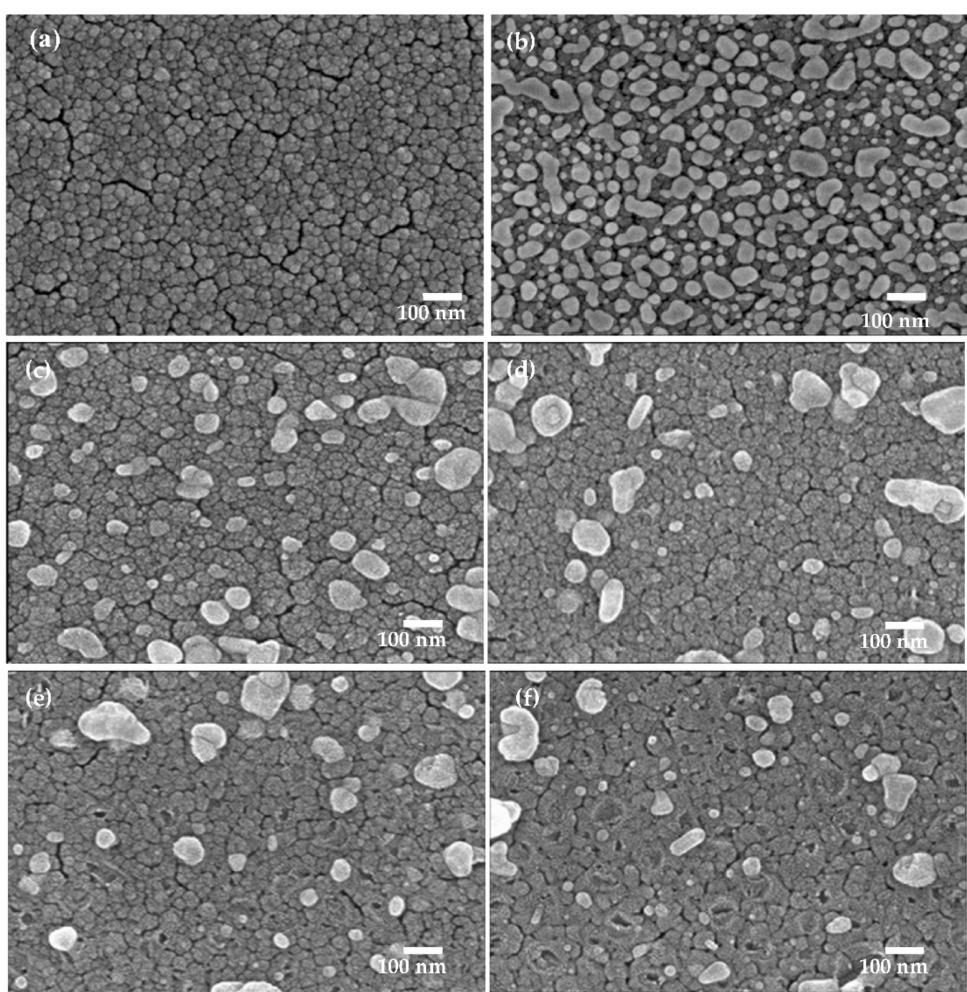
Figure 5. Surface morphologies of ( a ) the TiO x film, ( b ) the as-deposited TiO x /Ag structure, and the structures annealed at ( c ) 300, ( d ) 400, ( e ) 500, and ( f ) 600 ◦ C under nitrogen ambient for 1 min, conducted by FE-SEM observation.